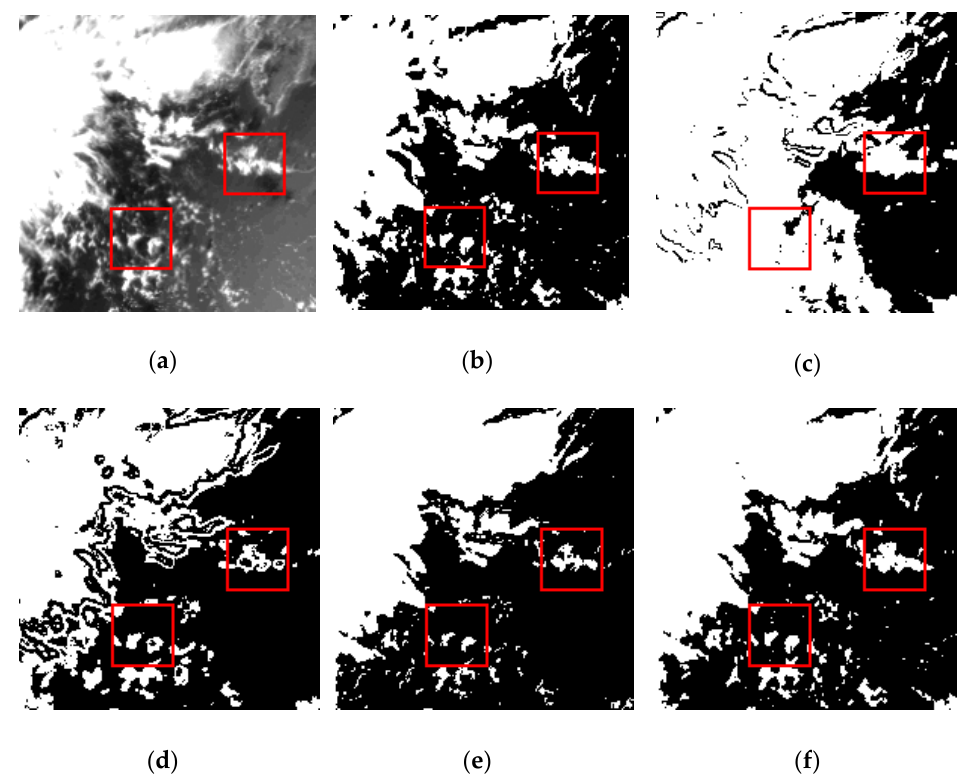
Figure 9. The enlarged subset of results. ( a ) Visible image; ( b ) Ground truth; ( c ) NSMC result; ( d ) NSMC-RF result; ( e ) Ensemble threshold-RF result; ( f ) Proposed RF result.